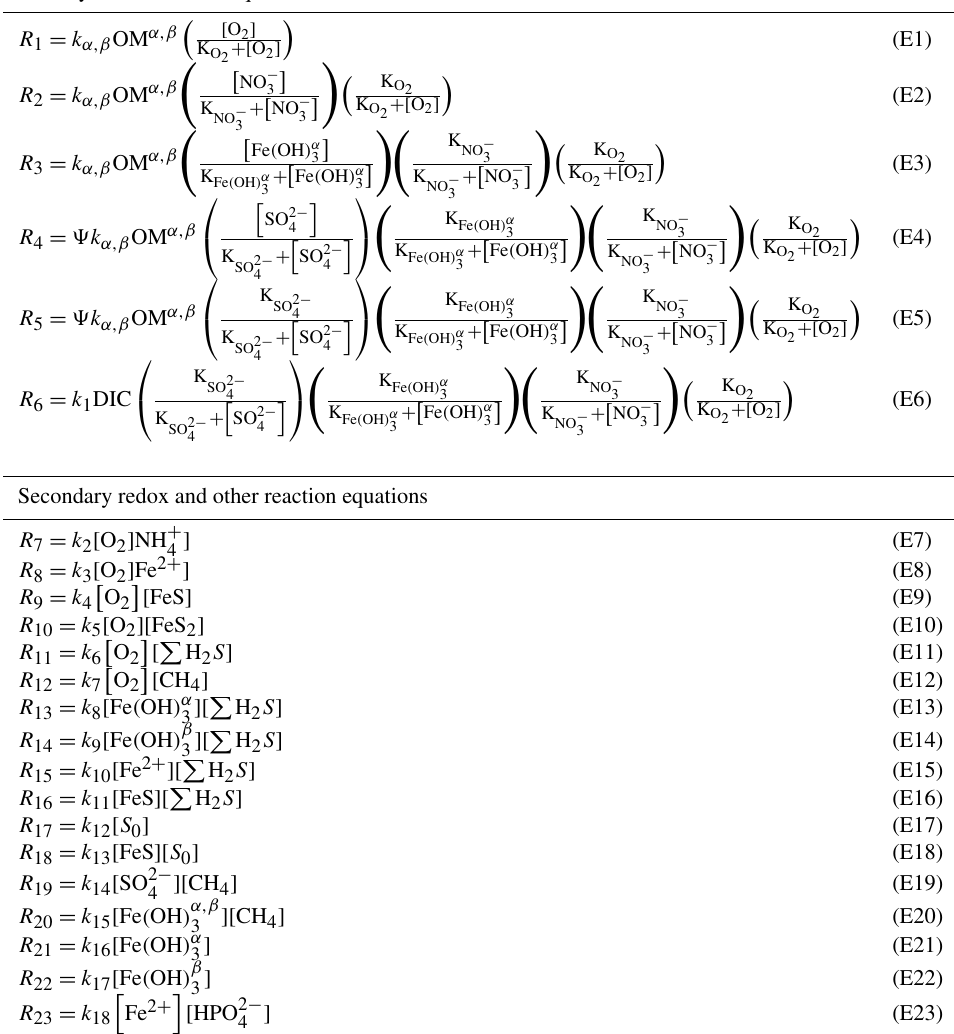
Table 4. Reaction equations implemented in the model. Primary redox reaction